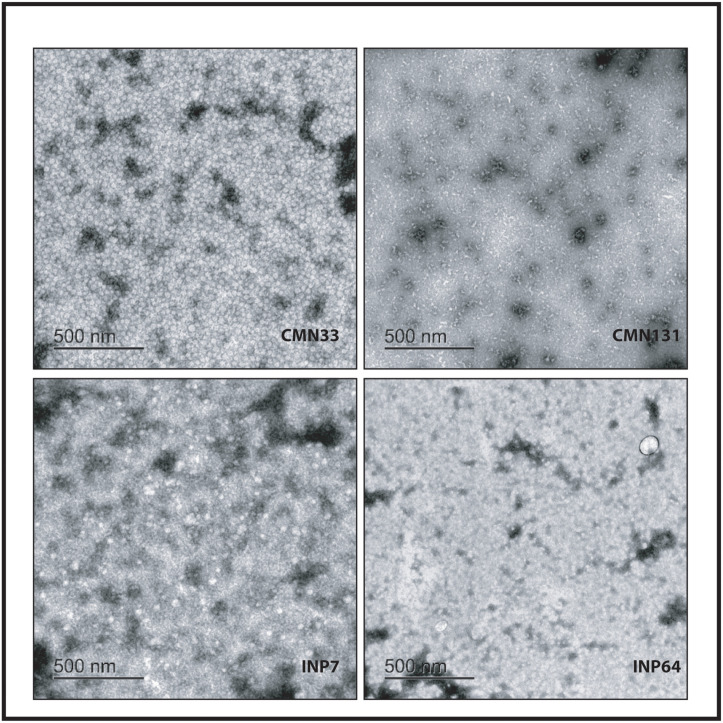
Representative electron microscopy images of RIAO from PTS of all the study groups.Codes of samples: CMN33:obesity; INP7:T1DM; INP64:T2DM; CMN131:healthy child.